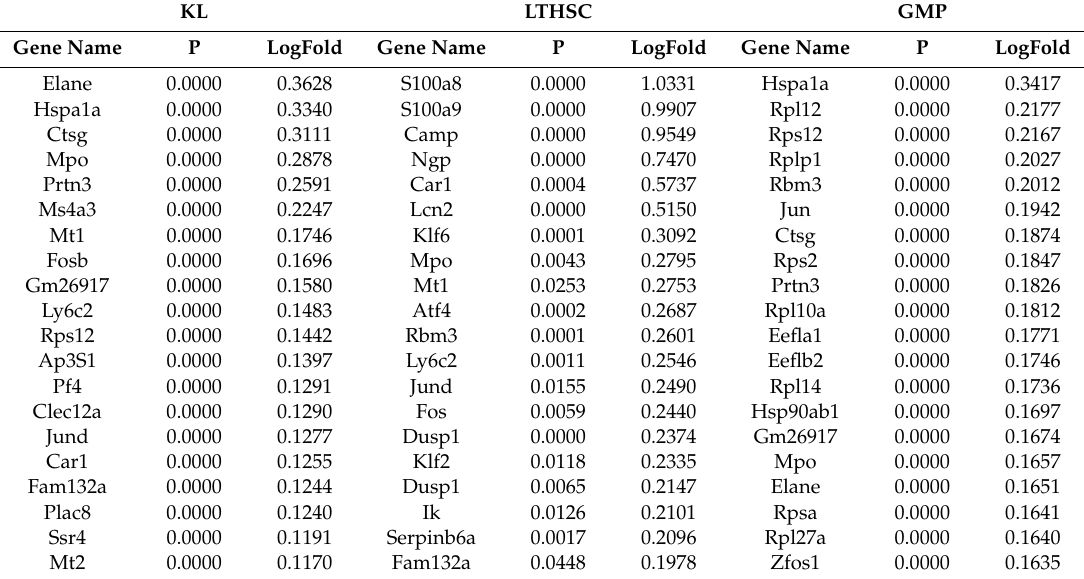
Table A2. Genes up-regulated in KL, LTHSC, and GMP hematopoietic cells from CVT mice at one month after co-housing relative to SPF